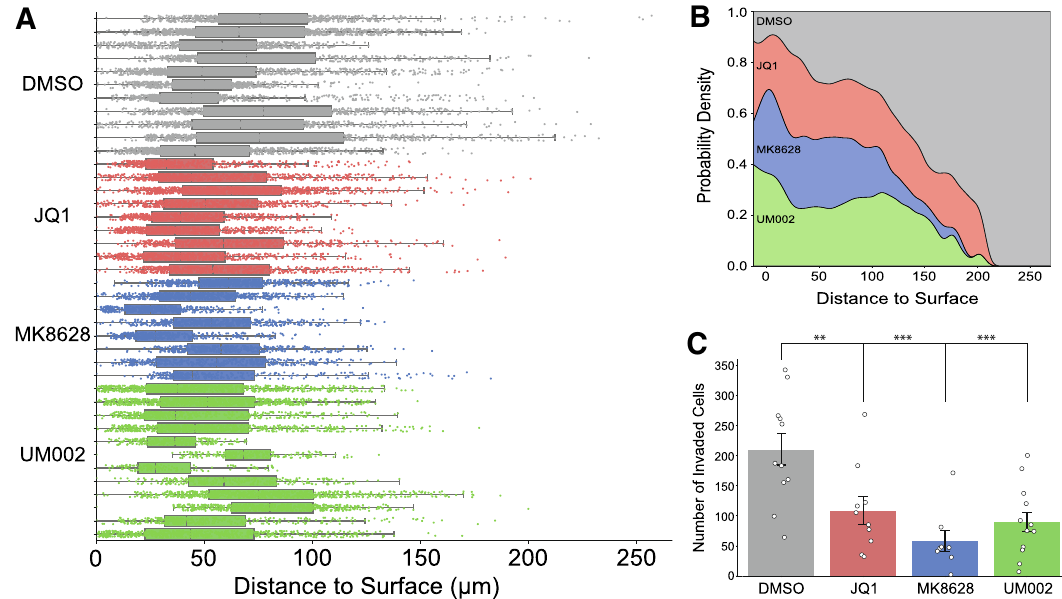
Figure 4. UM-002 reduces invasion of GBM cells into cerebral brain organoids. ( A ) GBM cell distance to the nearest organoid surface. Boxplots represent individual organoids; data points are individual GBM cells. Distance was normalized by setting the minimum distance for each organoid to 0. ( B ) Normalized stacked kernel density estimation (KDE) of GBM cell distance to organoid surface. ( C ) Number of GBM cells whose distance to the surface of the organoid exceeded the invasion threshold defined as the average third quartile value of the DMSO group. Statistical comparisons performed using a one-way ANOVA test with Tukey HSD post-hoc; ** ≤ 0.005; *** ≤ 0.001. Data shown are from three independent biological